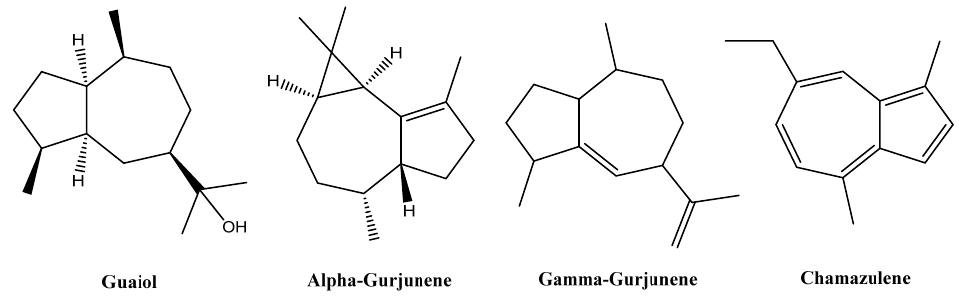
Figure 1. Chemical structure of the azulenes in A. absinthium essential oil.